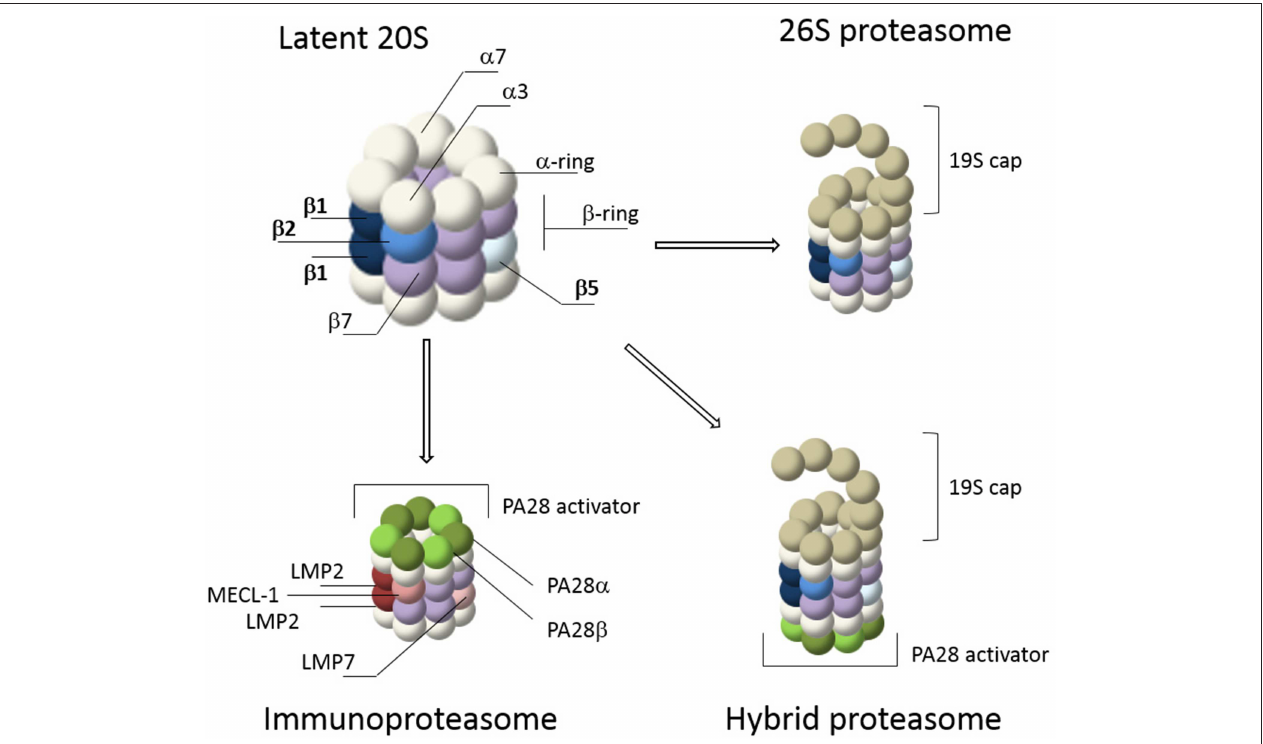
FIGURE 1 | Proteasome composition. The 20S core of the proteasome consists of 4 stacked rings. The outer rings contain seven α -subunits (white) while the inner rings contain seven β -subunits (purple). The catalytic subunits, β 1, β 2, and β 5, are depicted in shades of blue. Gate opening of the 20S core occurs via capping by proteasome activators such as the 19S cap or PA28. The 19S cap is the most abundant activator and it forms the 26S proteasome together with the 20S core. This is a simplified illustration of the 26S cap, a more detailed representation is reviewed elsewhere ( Lander et al., 2012; Collins and Goldberg, 2017). IFN- γ stimulation induces de novo formation of immunoproteasomes, including 26S immunoproteasomes, containing the immune subunits β 1i (LMP2), β 5i (LMP7), and β 2i (MECL-1) (shades of red), as well as proteasome activation by PA28 αβ (shades of green). Together these caps form hybrid proteasomes. In addition, proteasomes can also form complexes with the nuclear activation caps PA200 and PA28 γ (not